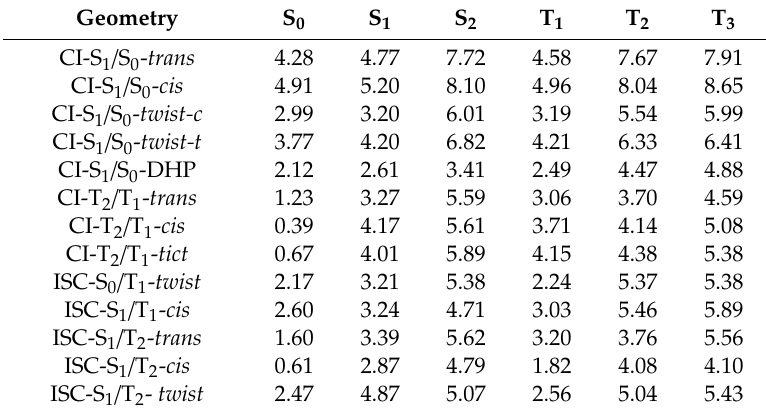
Table 4. The relative potential energies (in eV) calculated by MS-NEVPT2 method for the conical intersections and intersystem crossings optimized by SA6-CASSCF